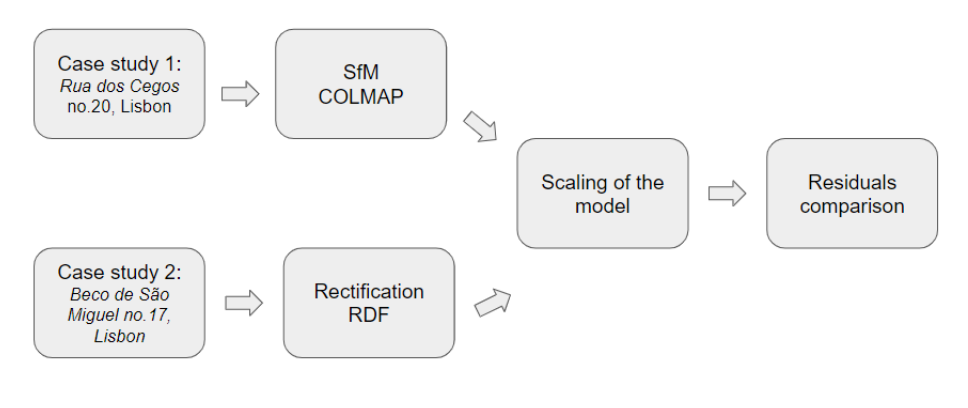
Figure 6. Workflow for the 3D reconstruction of selected case